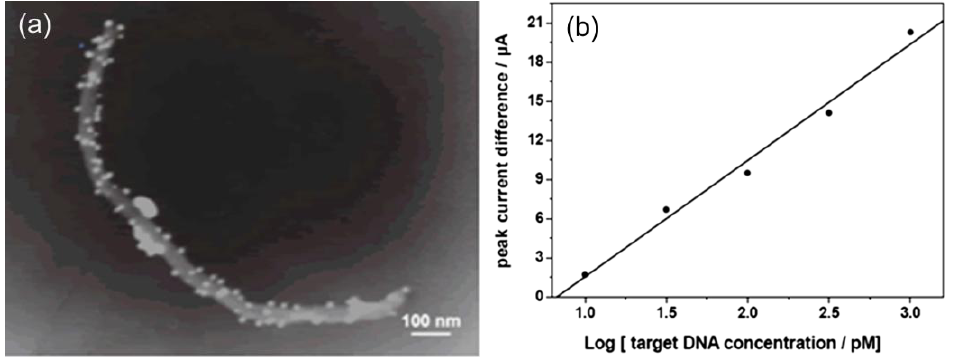
Figure 9. (a) TEM image of the Au/MWCNT nanocomposites. (b) Calibration current of the electroactive indicator (methylene blue) before and after hybridization. Differential pulse voltammetry measurements were performed at pulse amplitude of 50 mV and pulse width of 50 ms. Reprinted with permission from [100]. Copyright (2007) Taylor & Francis Group,